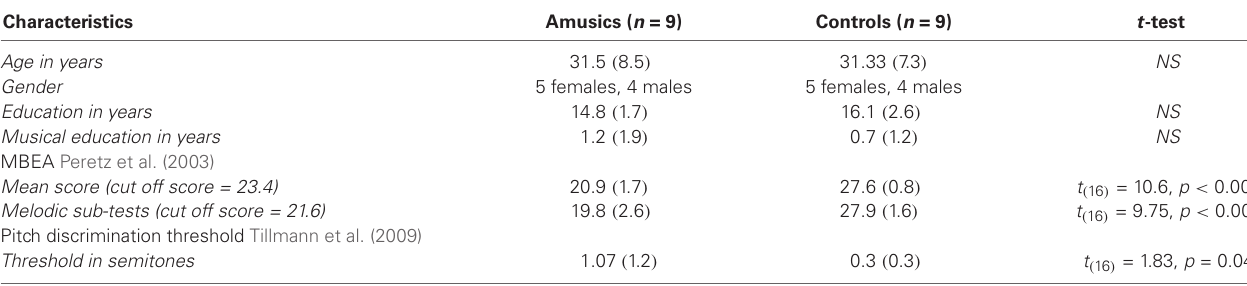
Table 1 | Demographic characteristics of participants and their data for behavioral pretests .